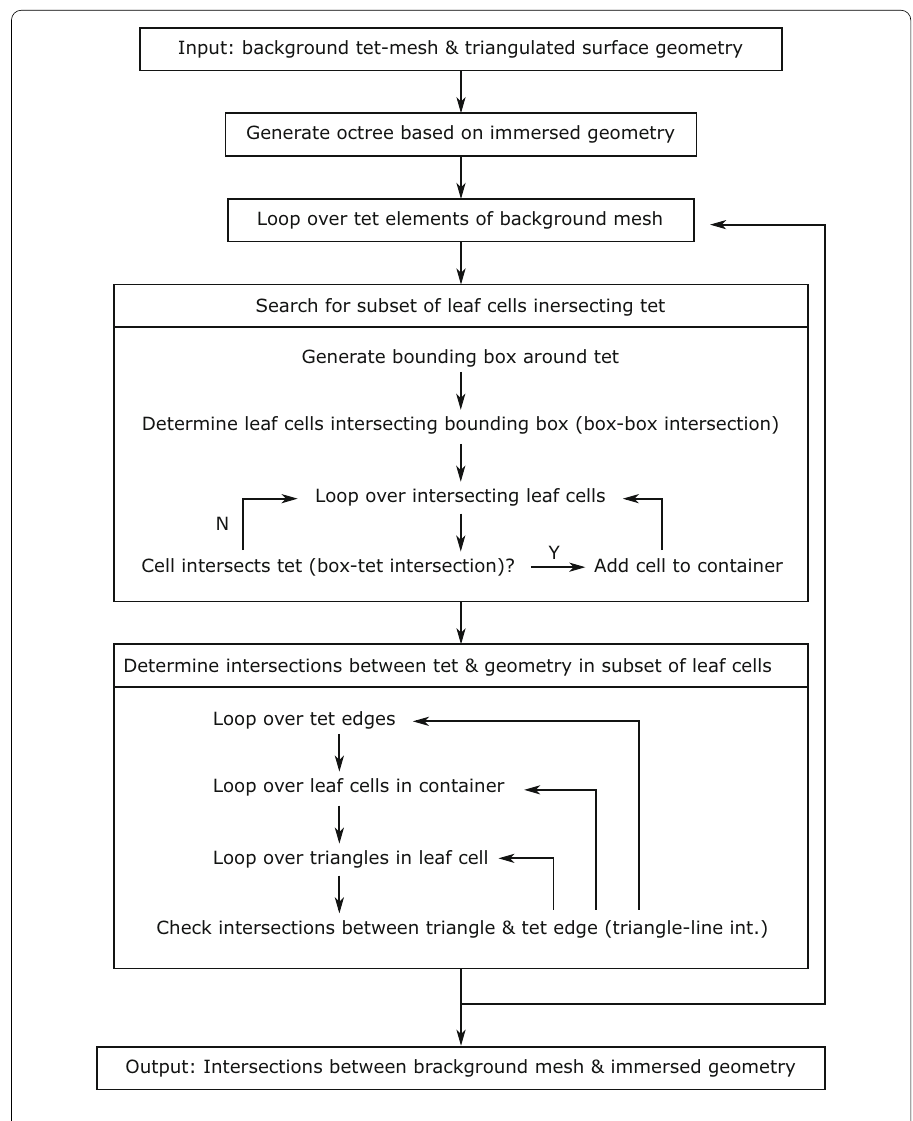
Fig. 6 Algorithm based on an octree data structure to determine intersection points between background mesh and immersed geometry